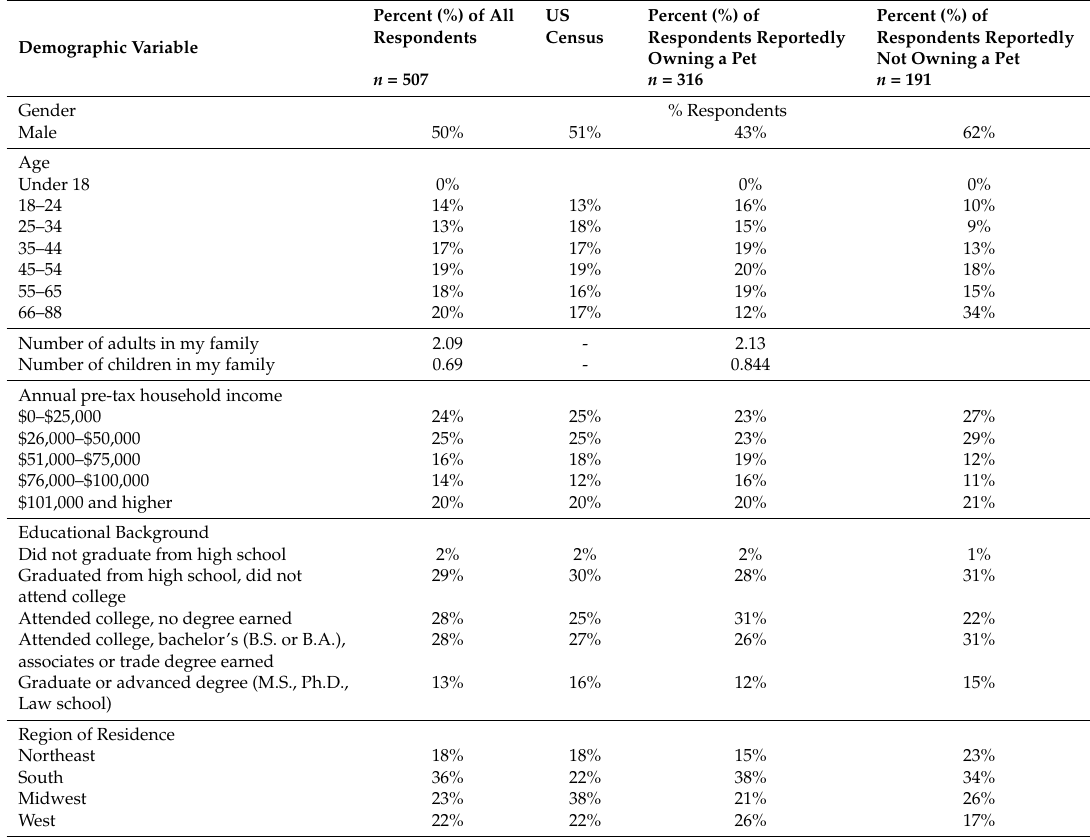
Table 2. Respondent demographics (% of